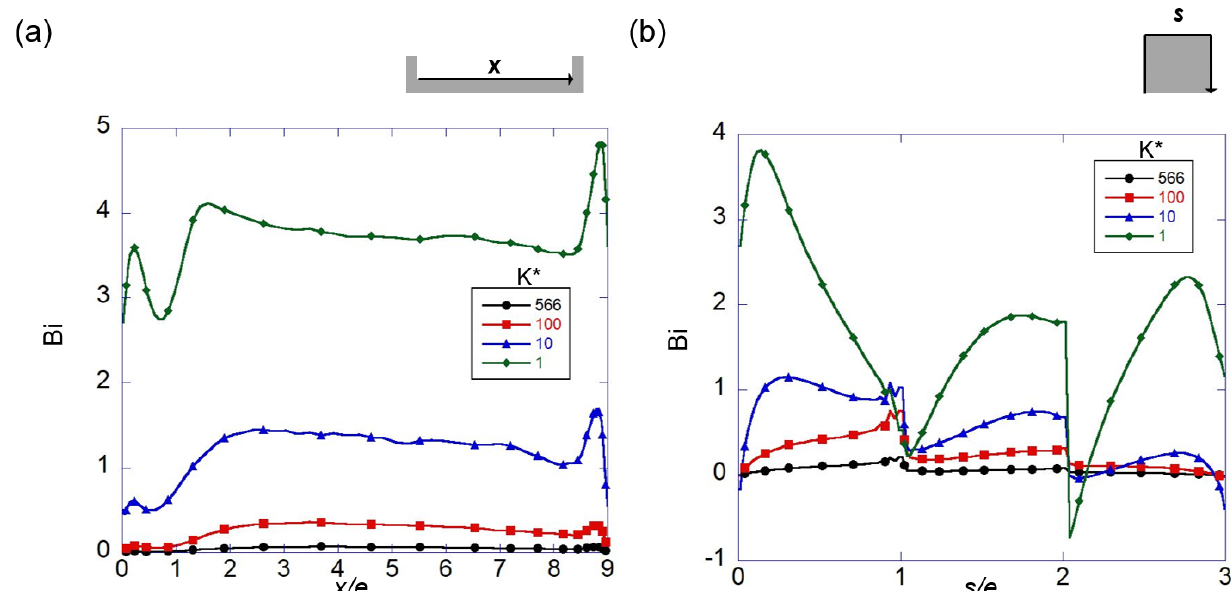
Figure 12. Local Biot number variations: ( a ) on the channel wall and ( b ) on the rib. At K* = 100 (red squares), Bi exceeds 0.1 at 3 < x/e < 6 on the channel wall, making the conduction thermal resistance non-negligible (Figure 12a), and at the rib surface, Bi goes up to 0.6 at the upstream edge (Figure 12b). At K* = 10 (blue triangles), Bi is close to 1, and the thermal resistance of the solid is similar to that of the fluid. About half of the temper- ature drop is expected in the solid region. The data for K* = 10 in Figure 5 shows that θ is around 0.4, confirming that the Biot number is an appropriate indicator. At K* = 1 (green